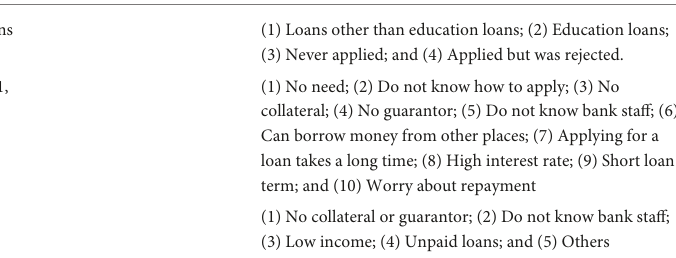
TABLE 3 Credit exclusion classification. Credit exclusion